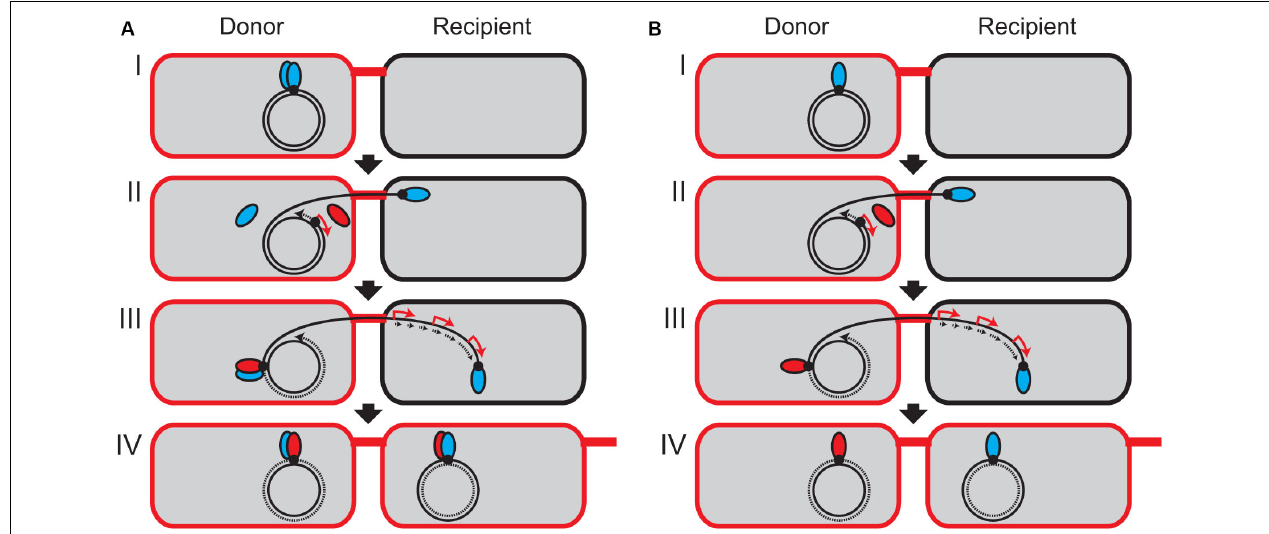
FIGURE 5 | Model of continuous plasmid transfer by induction of relaxase in the donor cell. It has not been experimentally verified whether TraI forms a dimer (A) or a monomer (B) in vivo . (I) At the oriT site (black dot), the TraI relaxase (blue ellipsoid) is covalently bound to the 5 (cid:48) end of tranfer strand. (II) One relaxase starts to be transported from the donor into the recipient. The 3 (cid:48) end of transfer strand serves as a primer to initiate the replication of replacement strand (dotted arrow). Since the traJ promoter region is the first to be replicated, the transcription of traJIH operon is temporally stimulated (red arrow) to express the second TraI relaxase (red ellipsoid). It is unknown whether only one TraI molecule has been transported into the recipient cell through the T4SS machinery. (III) In the donor cell, the induced relaxase or the remaining free monomer binds at the oriT site to reconstitute a new relaxosome complex and generates the unit-length ssDNA to terminate the plasmid transfer. In the recipient, the complementary strand is replicated (dotted arrows) and the transcription of plasmid genes are induced (red arrow). (IV) The rolling-circle replication is accomplished in the donor cell, and the transferred strand is recircularized in the recipient cell to be established as the new transconjugant